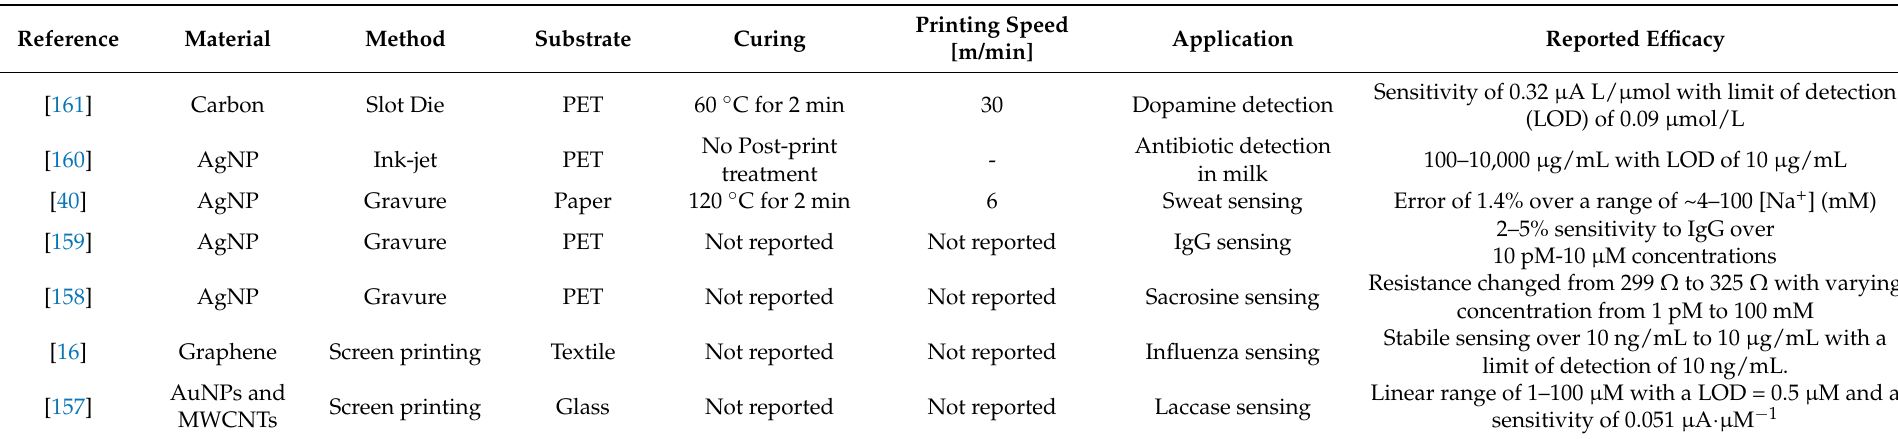
Table 3. High-throughput nanomaterial-based biosensor fabrication.